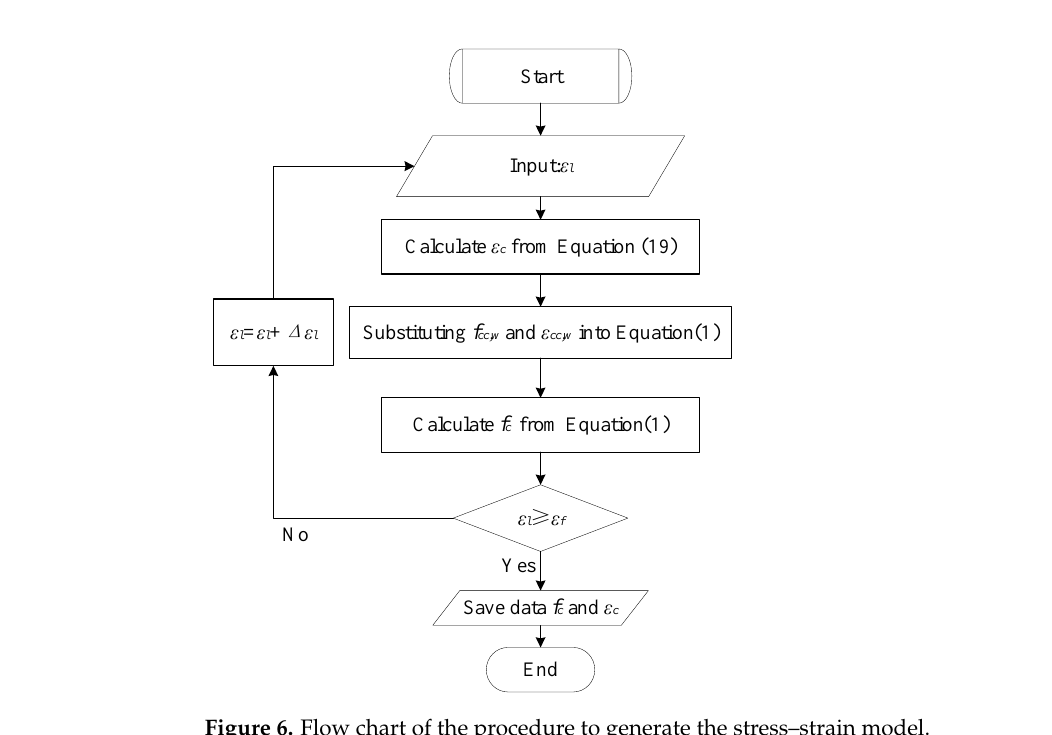
Figure 6. Flow chart of the procedure to generate the stress–strain model.